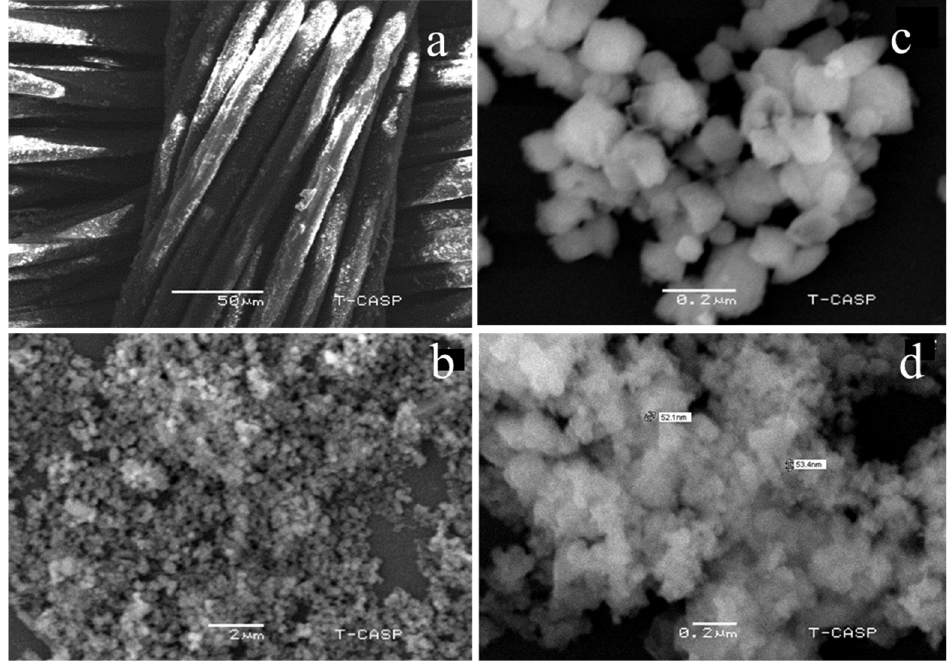
Figure 4. Micrographs of ( a ) Functionalized polyester with grafted nanocalcite at 10KX, ( b ) As-fab-